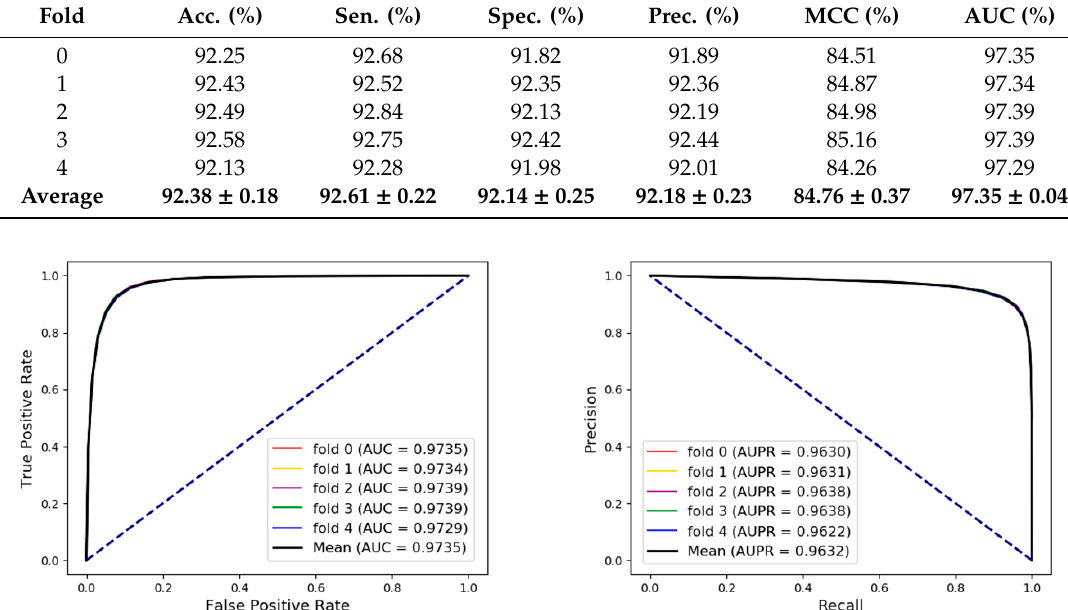
Table 3. Five-Fold cross-validation results performed by our method.